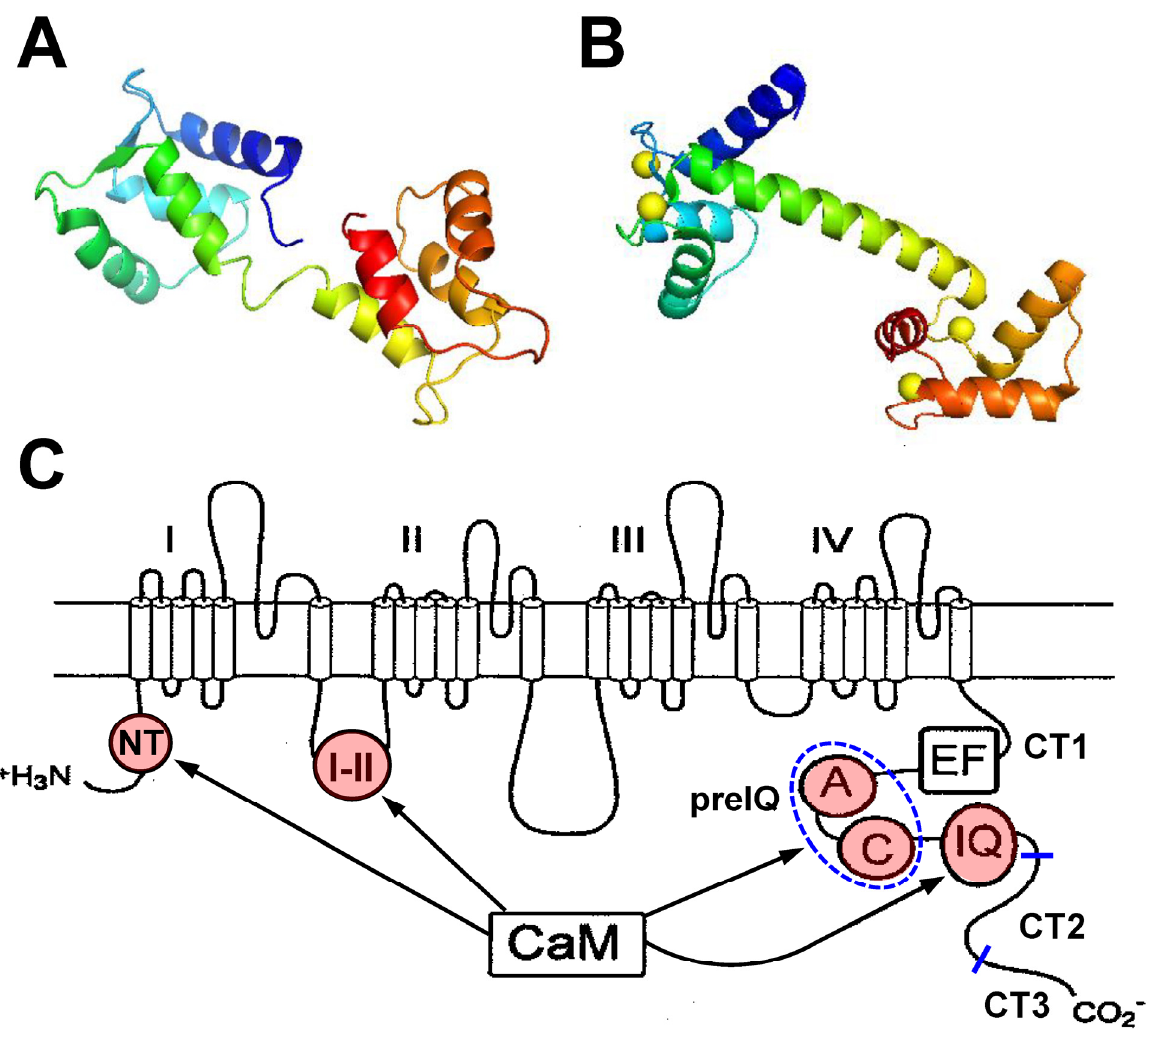
Figure 1. Structures of calmodulin (CaM) and the Cav1.2 Ca 2+ channel. ( A , B ) apoCaM (( A ), PDB:1CFD) and Ca 2+ /CaM (( B ), PDB:1UP5) shown in rainbow color from the N-terminus (blue) to C-terminus (red) with Ca 2+ indicated by the yellow spheres. ( C ) Schematic structure of pore-forming α 1C subunit of Cav1.2 channel. CaM binding sites are indicated in red and labeled as follows: NT, NSCaTE domain; I–II, a site in I–II loop; ( A , C ) regions of preIQ domain; and IQ, IQ domain. The C-terminal tail is divided into CT1, CT2, and CT3 regions.